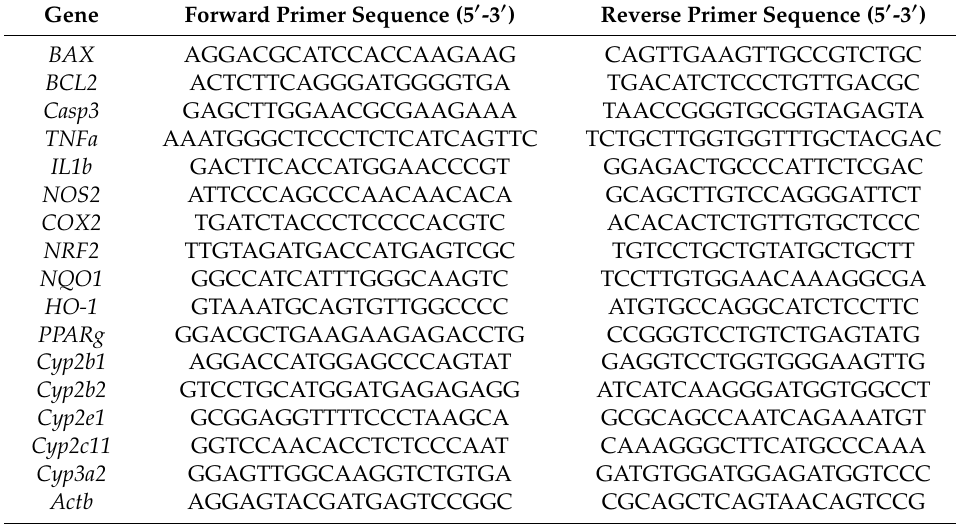
Table 1. Primers used for